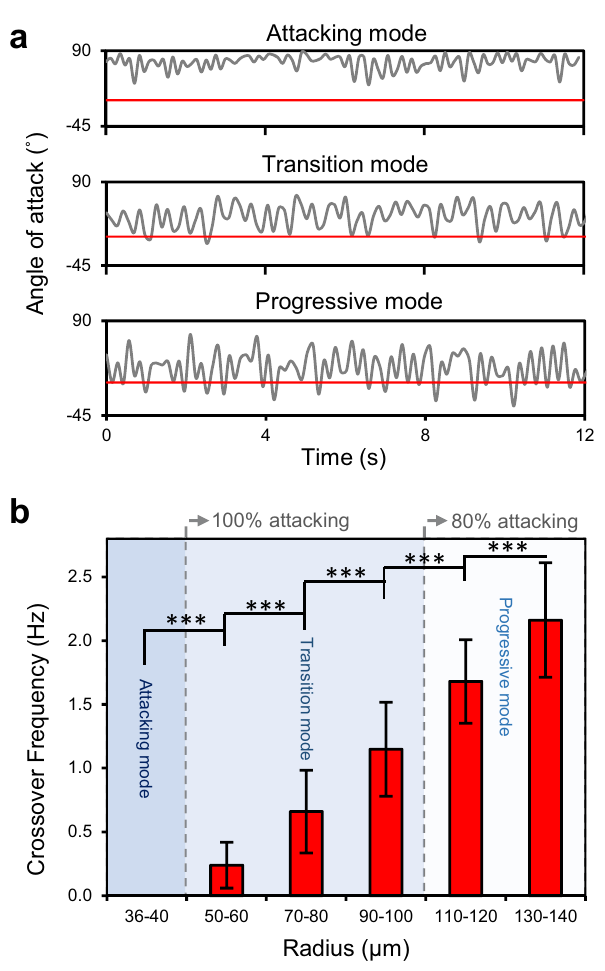
Fig. 3 Characterization of the temporal behavior of sperm in the attacking, transition, and progressive modes. a Representative variations of the angle of attack along the 12s tracked swimming trajectories for sperm swimming in the attacking, transition, and progressive modes. The horizontal red line indicates the threshold angle of attack of 2° for the sperm to align parallel to or depart from the interface. b Crossover frequency as a function of droplet radius. Values are reported as mean±s.d. ( n = 45, 46, 45, 46, 45, and 45 biologically independent cells examined over 5, 4, 4, 4, 5, and 4 independent experiments for sperm swimming in 36 – 40 µ m, 50 – 60 µ m, 70 – 80 µ m, 90 – 100 µ m, 110 – 120 µ m, and 130 – 140 µ m radius droplets, respectively), P values were determined using one-way ANOVA, *** P ≤ 0.001 (for exact P values see Supplementary Table 3), and for data distribution in ( b ) see Supplementary Fig. 10. Source data are provided as a Source Data fi